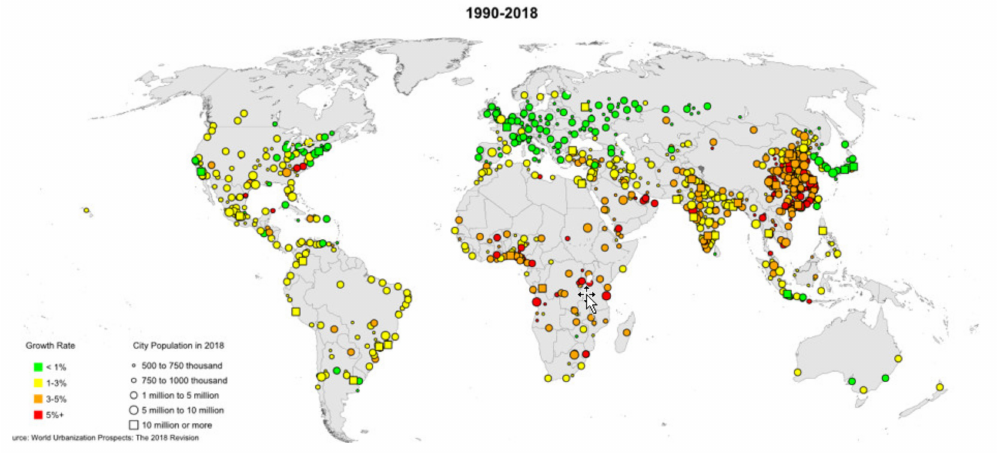
Figure 2. Growth rates of urban agglomerations by size class. Source: https://population.un.org/ wup/Maps/ (accessed on 2 August